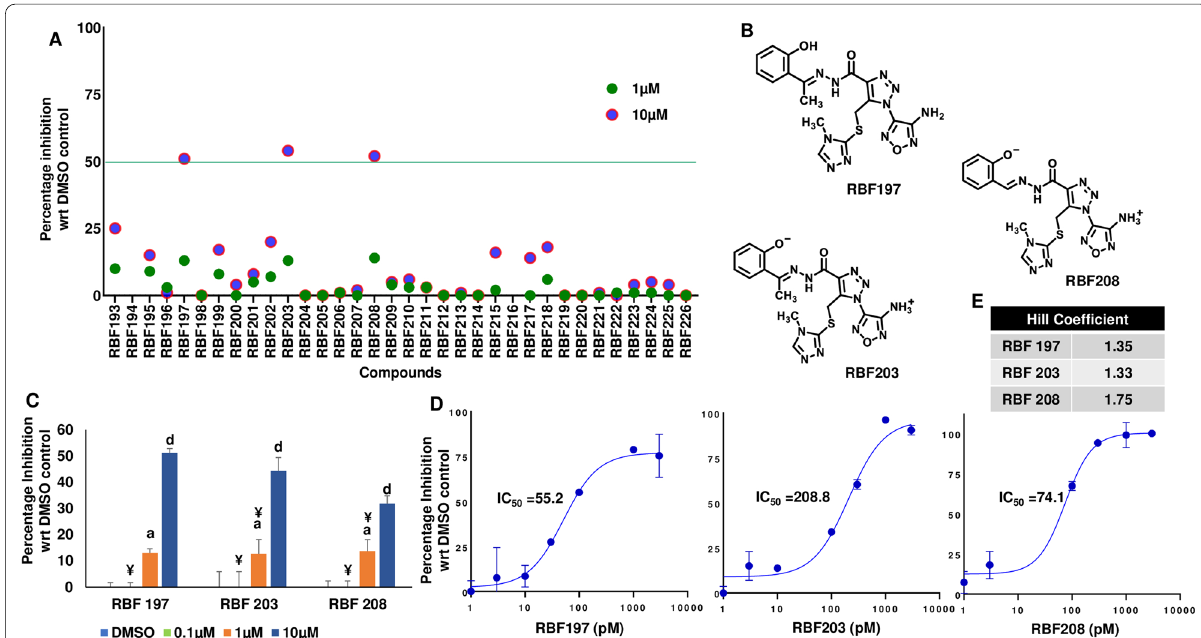
Fig. 5 Secondary screen and evaluation of RBF98 analogs. A A total of 34 compounds that inhibited Luciferase signal by 50% compared to ≥ control were identified. Luciferase activity results are expressed relative to values obtained in the presence of vehicle controls. Percentage inhibition was calculated and plotted in a scatter plot, n 3 biological replicates performed Mean SEM. B Structures of RBF197, RBF203, and RBF208, potent = ± candidate inhibitors. C Representative plots of percentage inhibition values of luciferase activity on the treatment of RBF 197, RBF203, and RBF208 at 0.1, 1, and 10 µM in eIF4A1-3X-Luciferase in Hek293T/17 cell lines for 24 h (n 3). Statistical analysis was performed using one-way ANOVA followed = by Bonferroni’s correction analysis. a p < 0.05; c p < 0.001, d p < 0.0001 vs DMSO control groups, α p < 0.05, β p < 0.001, ¥ p < 0.0001 vs 10 μM treatment groups. D Concentration–response curves of percentage inhibition of human eIF4A1 in-vitro activity on the treatment of RBF197, RBF203, and